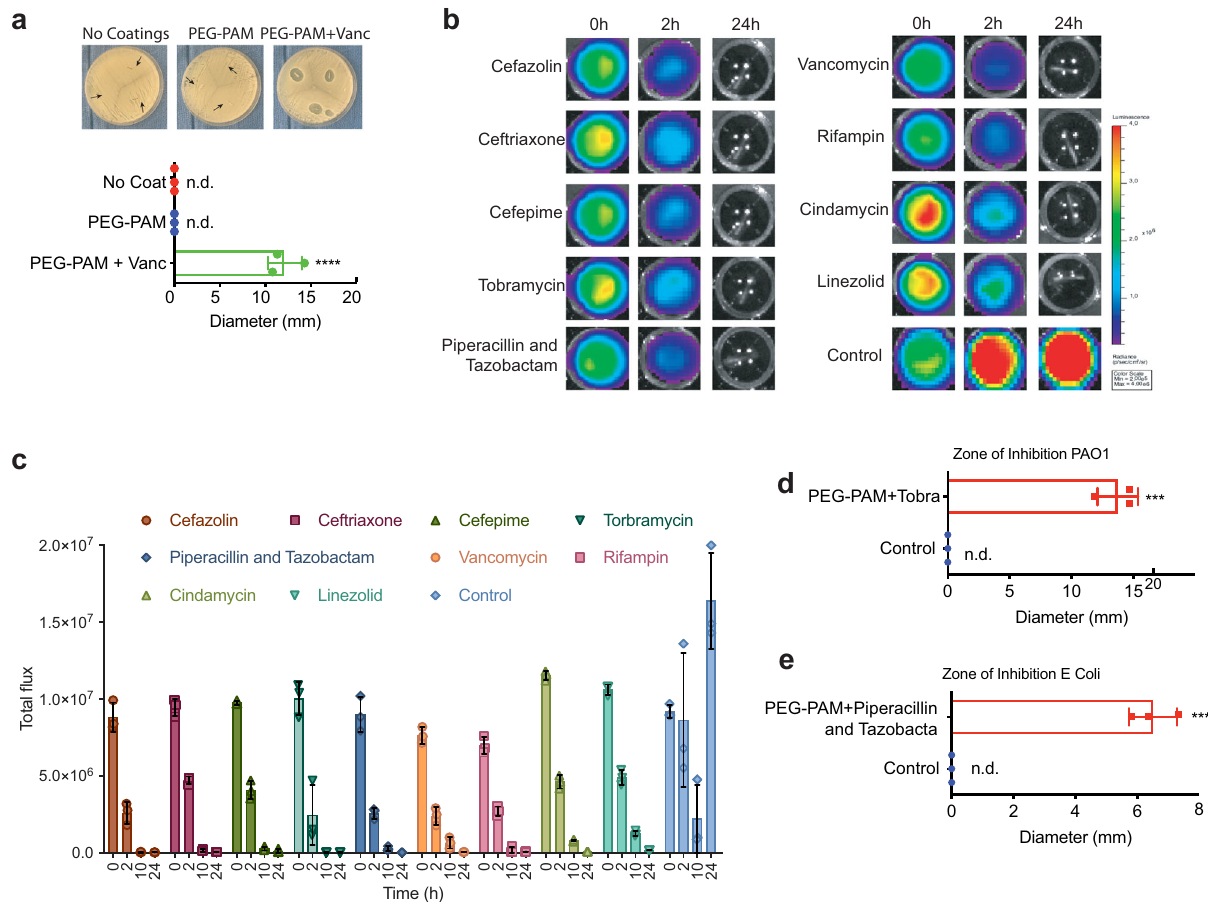
Fig. 3 In vitro evaluation of antibiotic loaded PEG-PAM coatings. a Representative ZOI images of titanium pins with no coatings, PEG-PAM coating only, PEG-PAM coating with vancomycin against S. aureus . ZOI diameter measurement of titanium pins with no coatings, PEG-PAM coating only, PEG-PAM coating with vancomycin. b Representative in vitro S. aureus bioluminescence on 96 wells plate with PEG-PAM coatings containing different antibiotics, and the control group is uncoated pins. c Quanti fi cation of in vitro S. aureus bioluminescence on 96 wells plate with PEG-PAM coatings containing different antibiotics and the control group is uncoated pins. d , e ZOI diameter measurement of titanium pins with PEG-PAM coating only, PEG-PAM coating with Tobramycin against PAO1, with PEG-PAM coating only, PEG-PAM coating with Piperacillin and Tazobactam against E. coli. f Quanti fi cation of in vitro S. aureus bioluminescence of established bio fi lm on 96 wells plate before and after PEG-PAM vancomycin (PPV) coatings. Statistics in ( a ) are an ordinary one-way ANOVA with a Tukey Multiple comparison ’ s test ** p < 0.0001. Statistics in ( d ) and ( e ) are two-tailed Student ’ s t -test *** P < 0.001. Data is plotted showing the Mean and Standard Deviation. Biological replicates derived from independent experiments are shown in each panel as a dot ( n = 3 for all